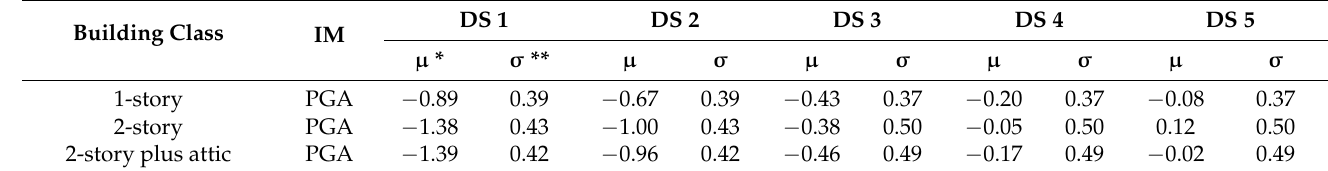
Table 6. Fragility parameters for adobe